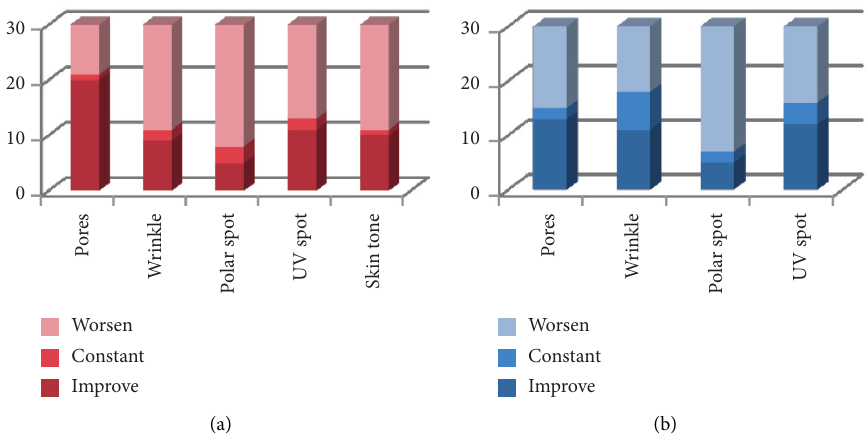
Figure 1: A comparison of the first and second observations between the control (a) and treatment (b)